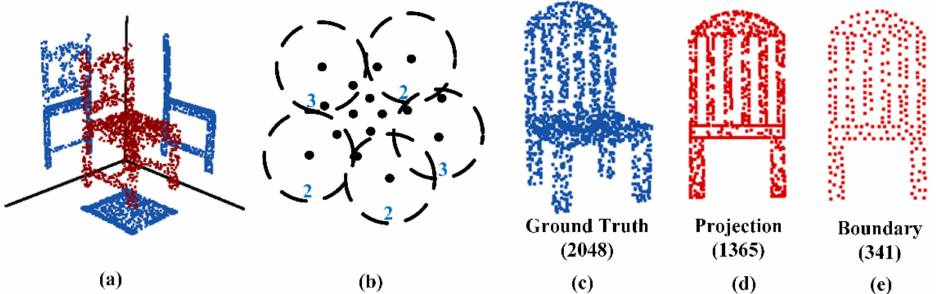
Figure 3. Projection transformation and boundary extraction. ( a ) Projection transformation projects the point cloud (indicated in red) onto three planes (indicated in blue). ( b ) Boundary extraction algorithm extracts the number of neighbors around each point (indicated in black). A group of points with the least number of adjacencies is selected as boundary feature points (indicated in blue). ( c – e ) Projection transformation and boundary extraction of the point cloud (indicated in blue) in a certain direction (indicated in